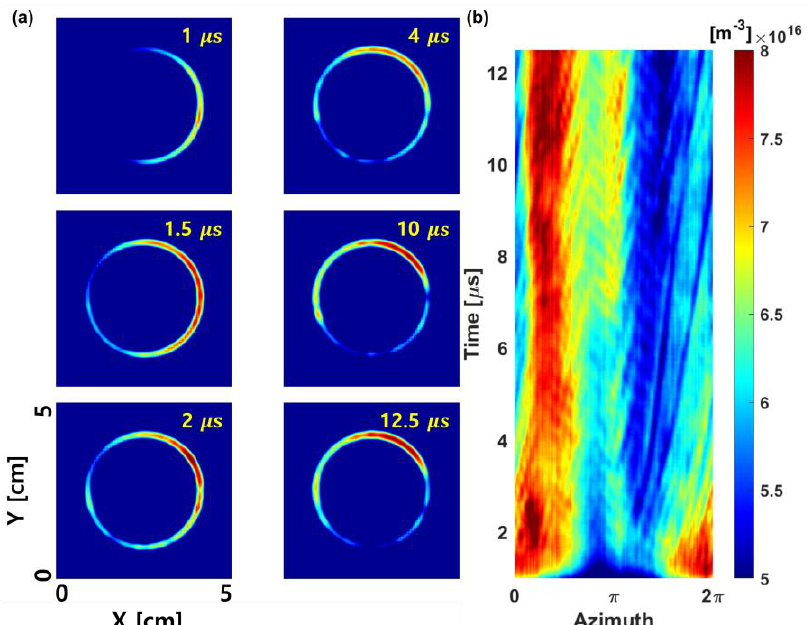
Figure 12. Time evolution of ( a ) spatial distributions of plasma density in xy plane with the sym- metric magnet and ( b ) azimuthal distributions of the plasma density.